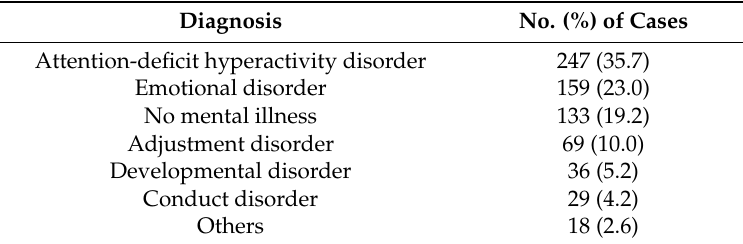
Table 1. Breakdown by diagnosis for the cases seen in